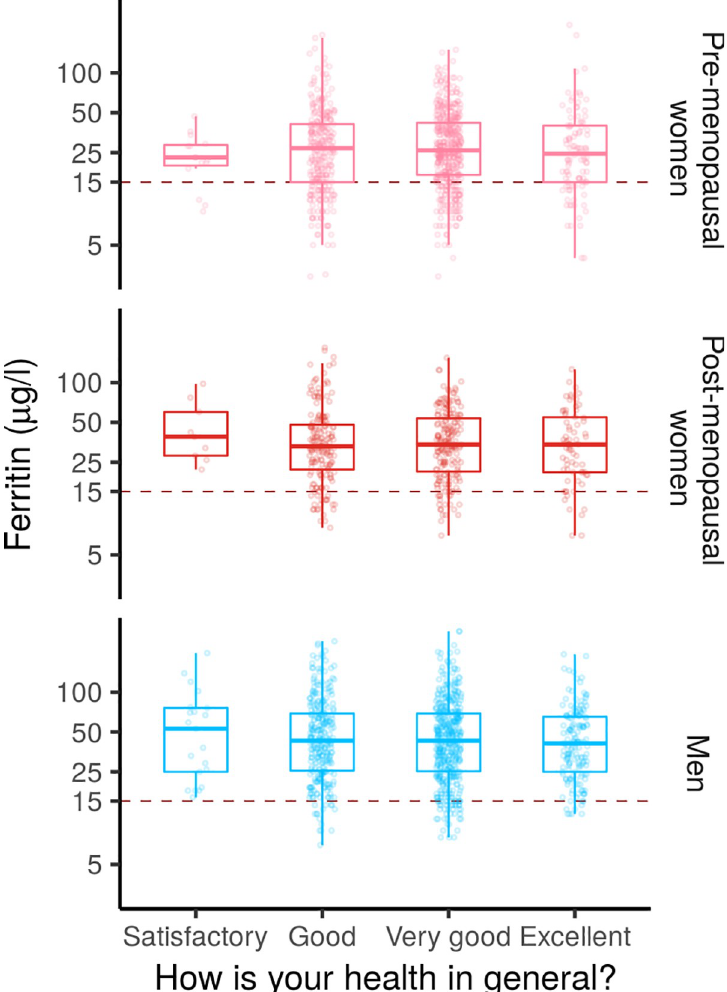
Fig 4. Self-reported health is not affected by donor iron levels. Donor ferritin levels are plotted as a function of their self-reported health status and standard boxplots are superimposed for each self-reported health status.